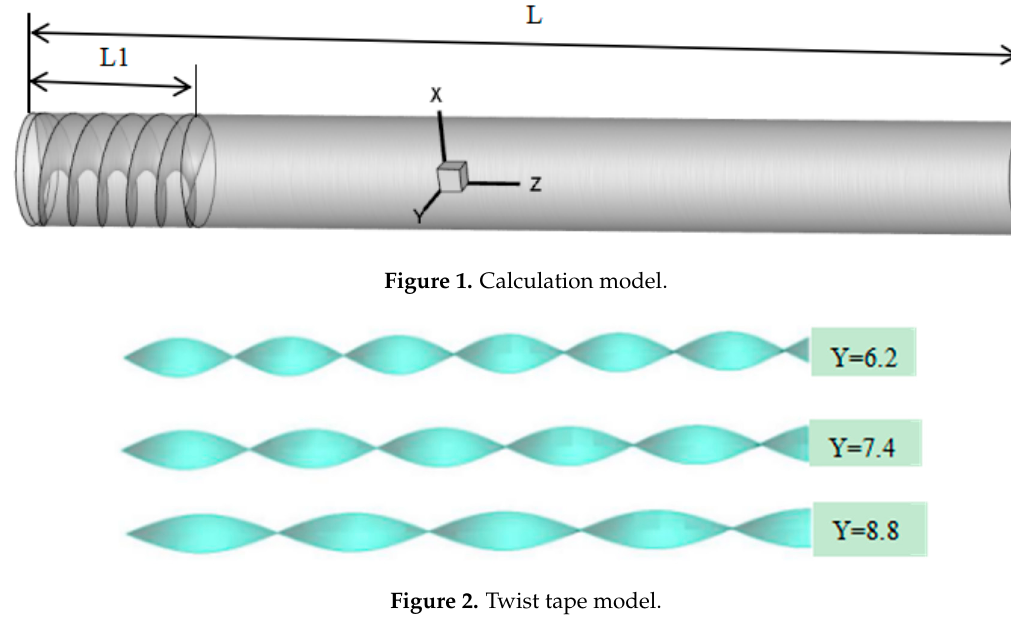
Figure 2. Twist tape model.